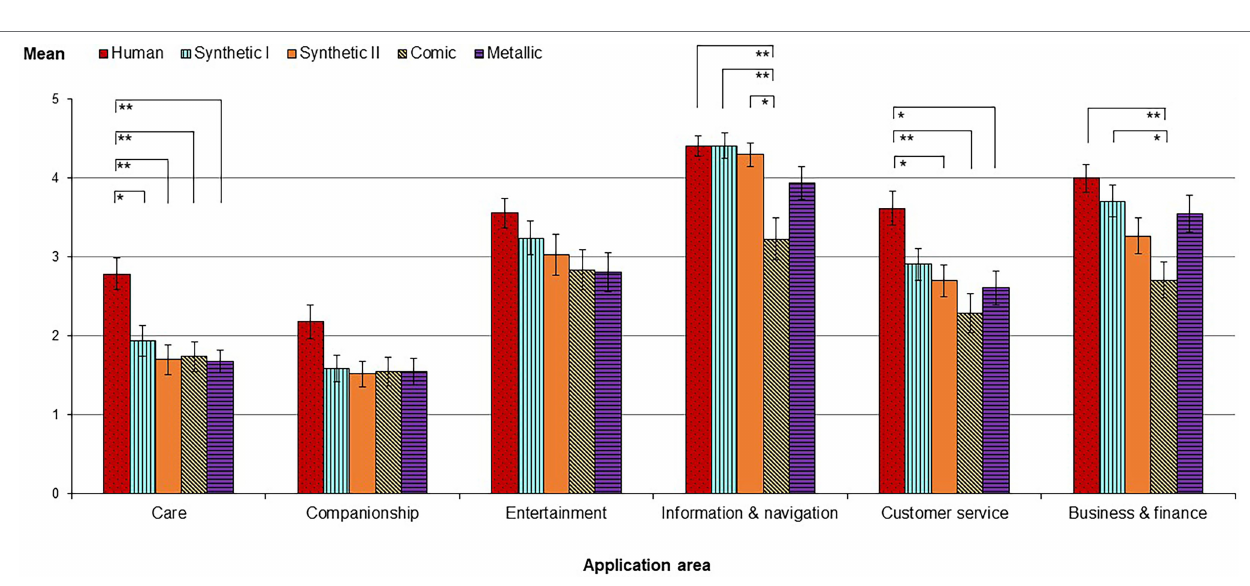
FIGURE 3 | The bar chart shows the mean values of acceptance of the five different voices depending on the respective context. A Kruskal–Wallis test was used for pairwise group comparisons (** p < 0.01; * p <